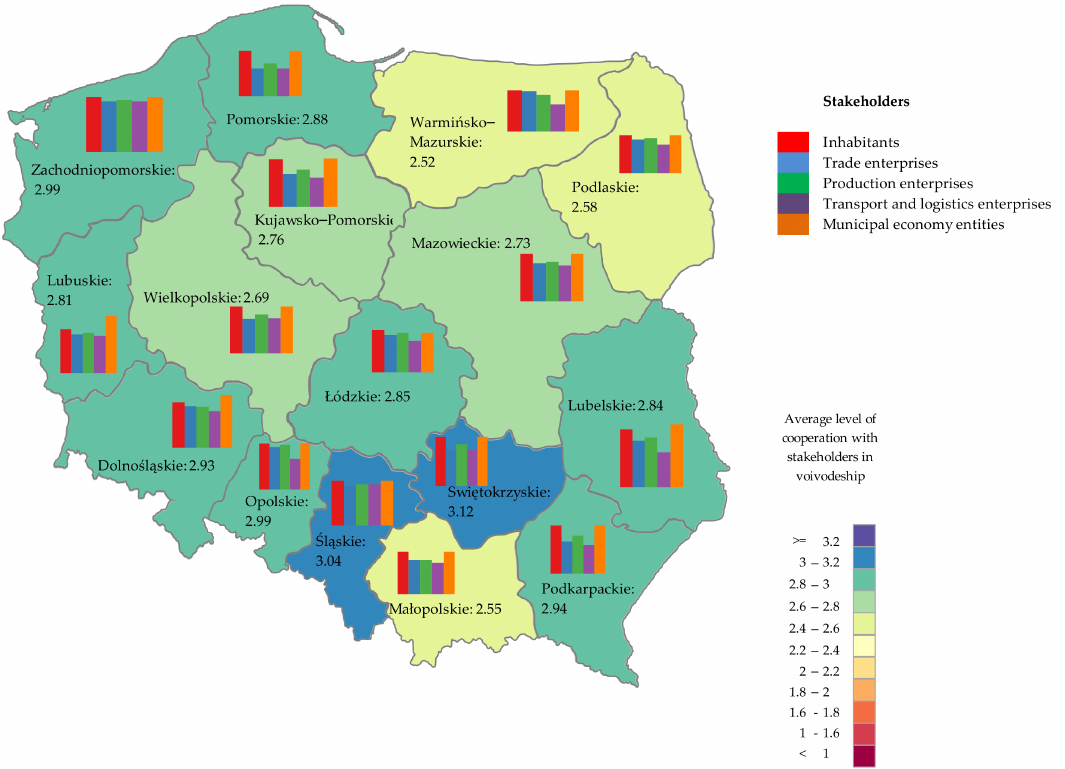
Figure 7. Level of cooperation between cities and stakeholders by